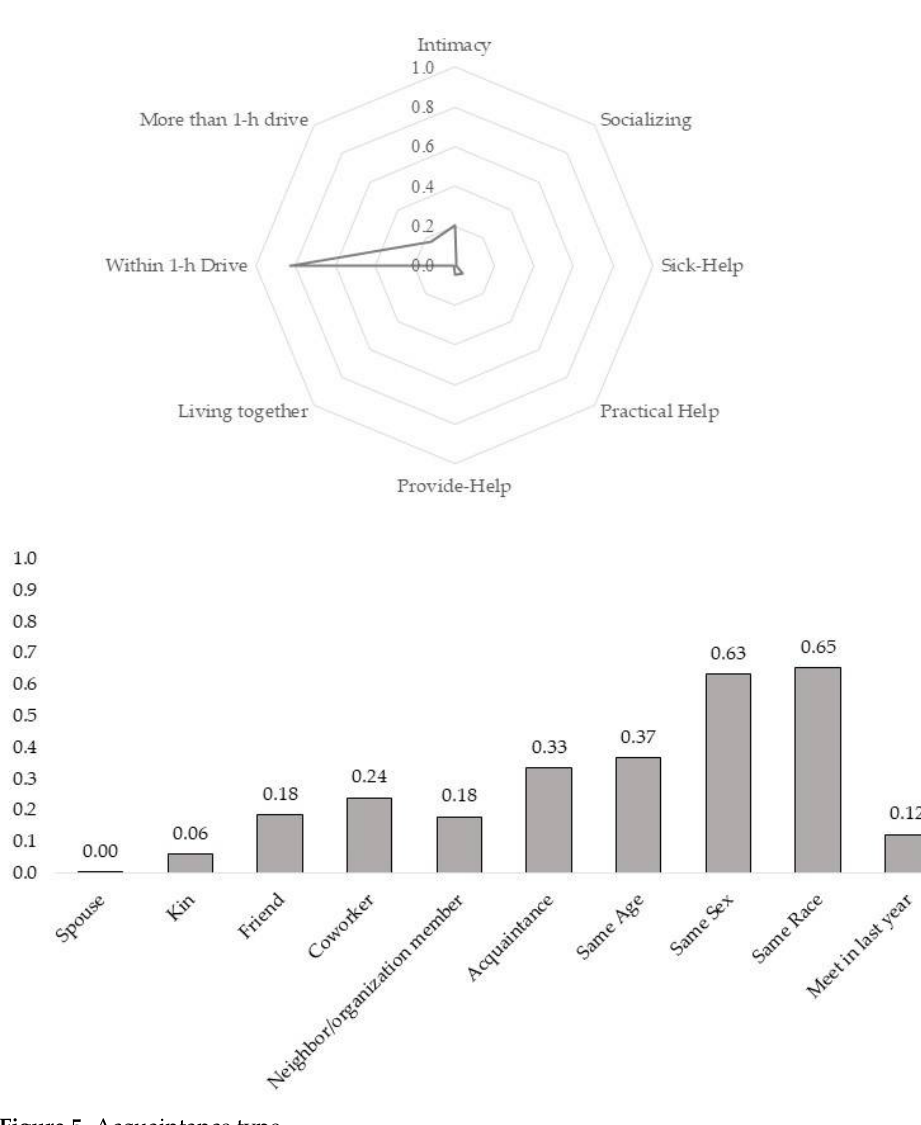
Figure 5. Acquaintance